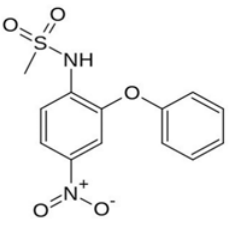
Figure 1. Structual formula of nimesulide